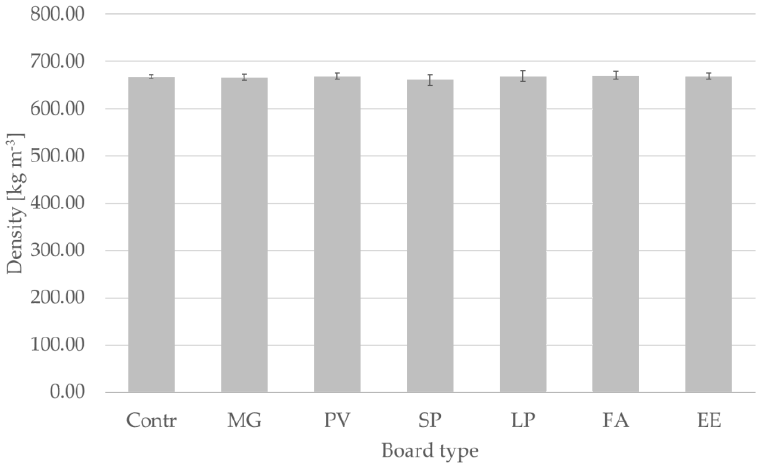
Figure 7. Density of manufactured panels. Abbreviations used: contr. — control (100% wood); FA —